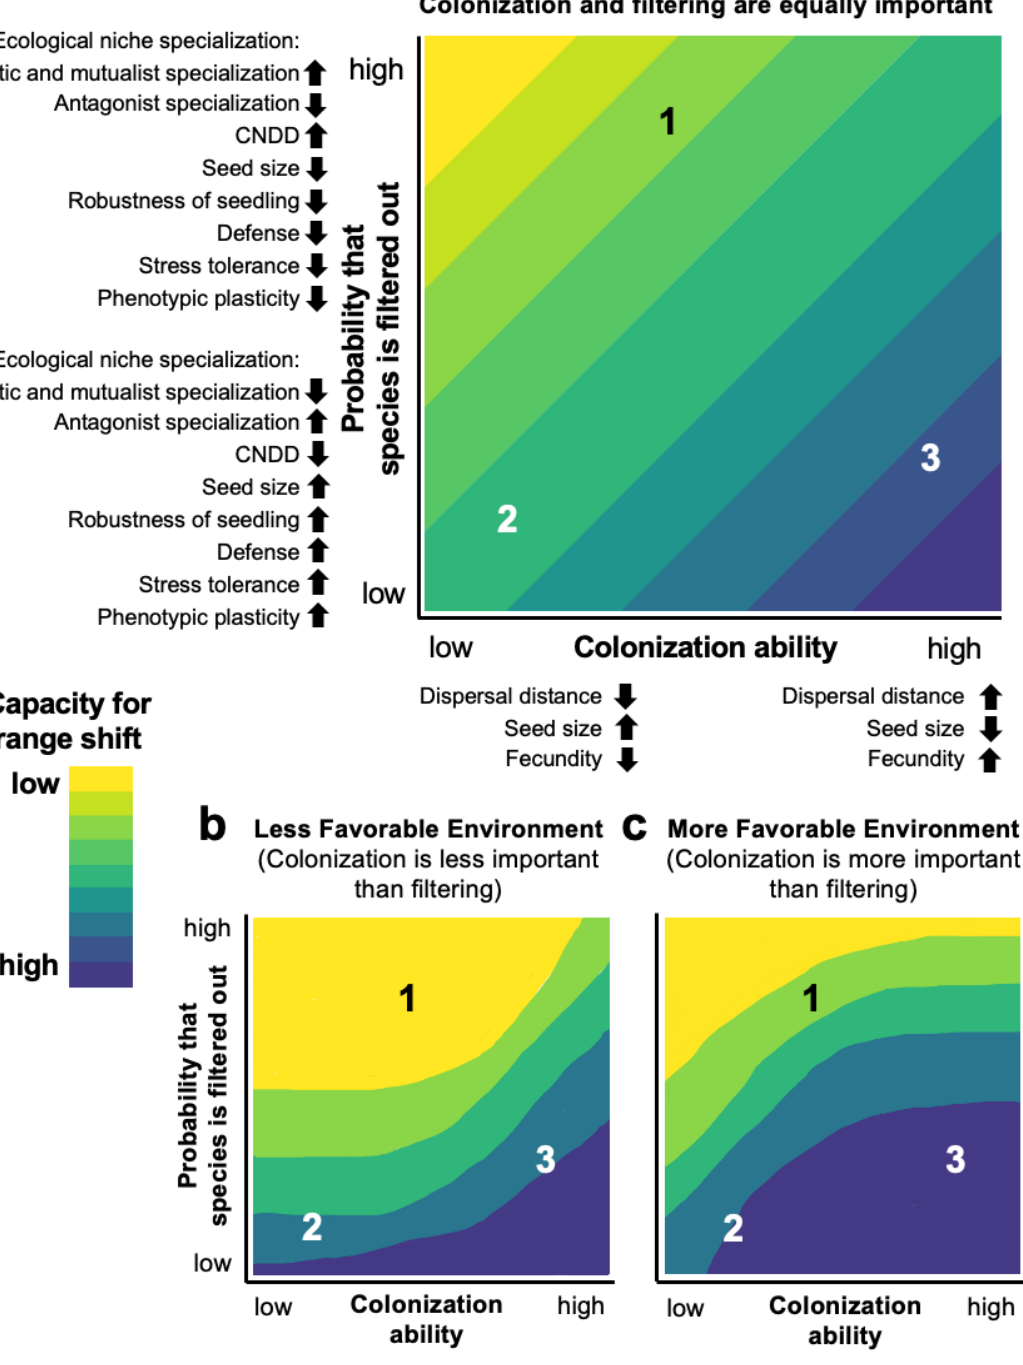
Figure 2. A plant species’ capacity for range shifts is shaped by the relationship between its colonization ability and its probability of being filtered out of a site. The capacity for plant range shifts is determined equally by the effects of colonization ability and the probability that a species experiences habitat filtering (i.e., is filtered out of a site) after colonization in ( a ), is more limited by a species’ probability of being filtered out in ( b ), and is more limited by a species’ colonization ability in ( c ), with low (yellow) to high (purple) capacity for range shift. Trade-offs in species’ ecological strategies influence their colonization ability and their probability of being filtered out of a site through a phenotype–environment mismatch. Trait values that should increase or decrease colonization ability or probability of being filtered out are denoted on the high and low ends of each axis and apply to all three graphs, even though they are only detailed in ( a ). The numbers 1, 2, and 3 represent the positions of three hypothetical species positioned on the x and y axis coordinates based